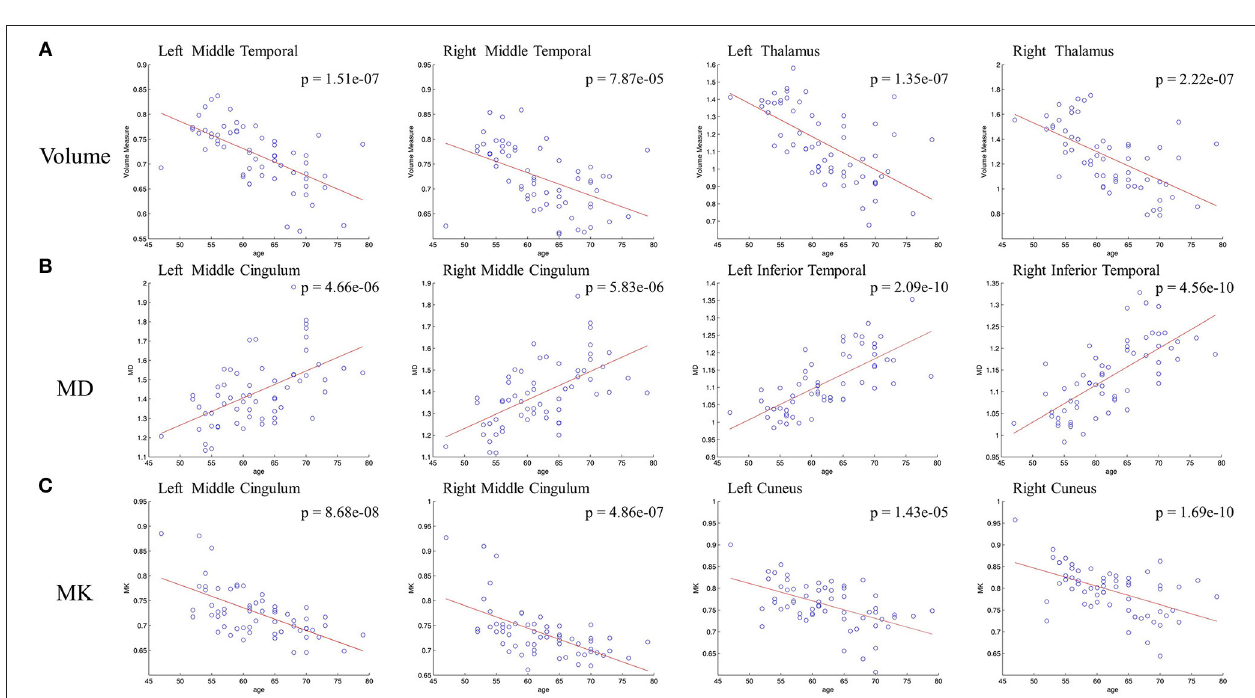
FIGURE 2 | Scatterplots of the linear age effects on (A) GM volume and DKI indexes [MD (B) and MK (C) ] in representative regions. Significant decrease were observed between GM volume and age, also between MK and age. Significant increase was observed between MD and age.